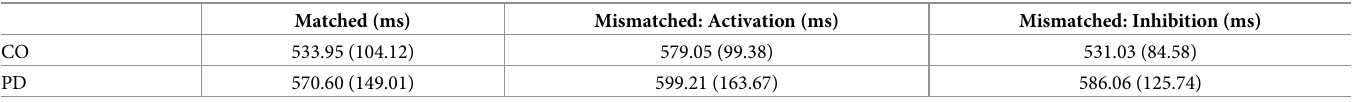
Table 2. Reaction time (ms) for control, activation, and inhibition trials. Values are mean reaction time (SD) in milliseconds (ms) from target presentation. Matched (ms)